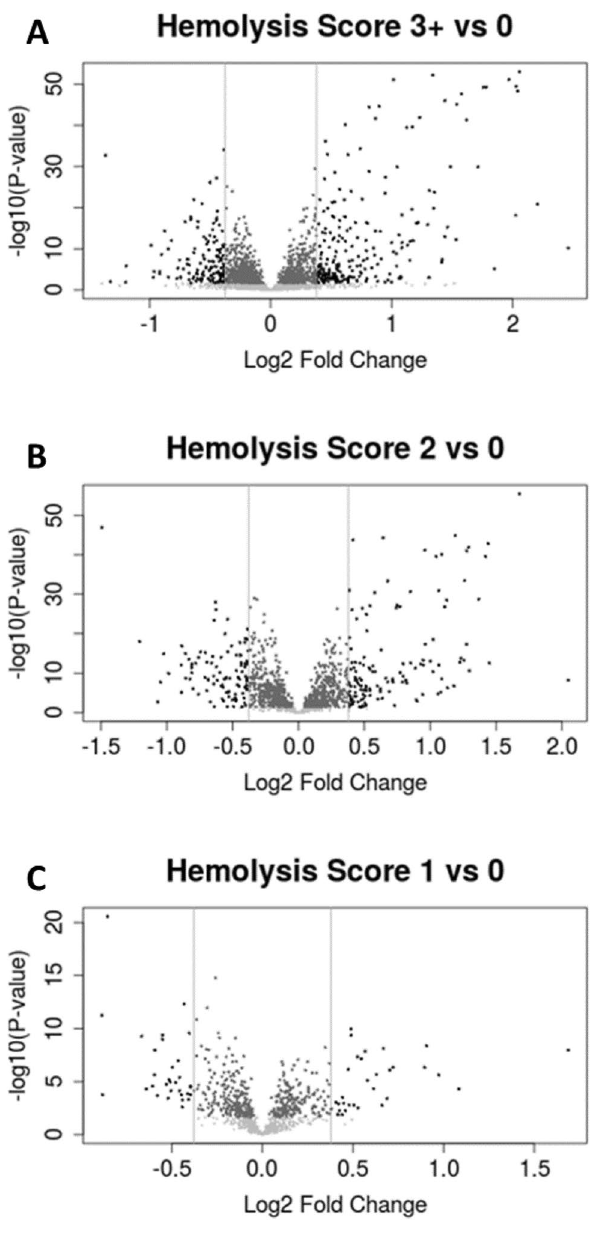
Figure 4. Volcano plots showing a comparison of protein expression between 3 versus 0, 2 versus 0 and 1 versus 0. The expression of protein ratio to the QCP was exhibited as Log2 fold and compared to − Log10 of p value. Significant proteins required minimum 1.3 fold-change difference and maximum p value of